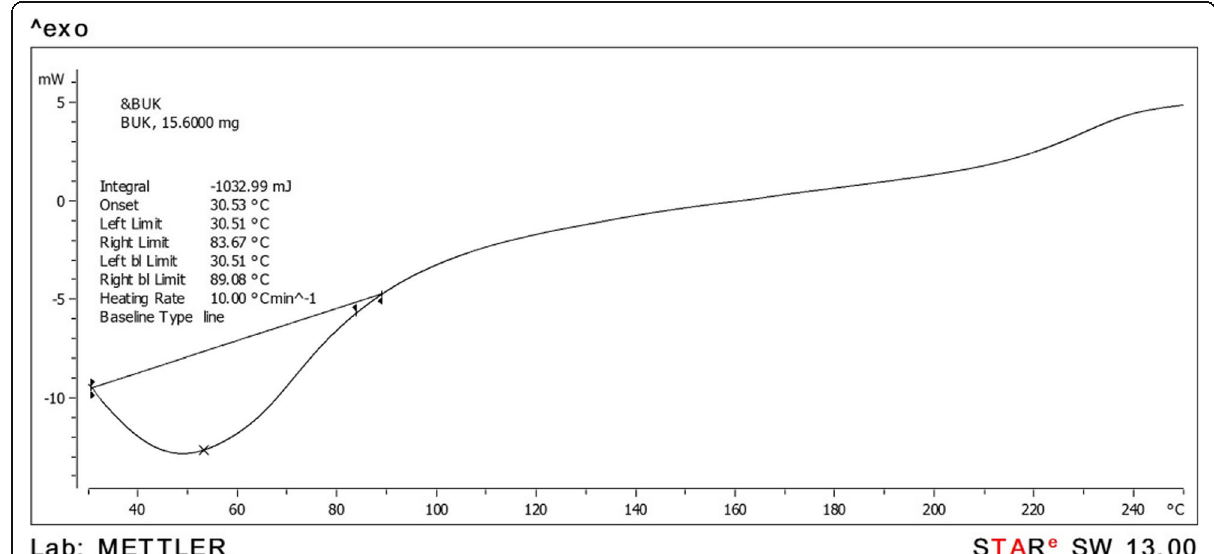
Fig. 2 DSC thermogram of Khaya senegalensis